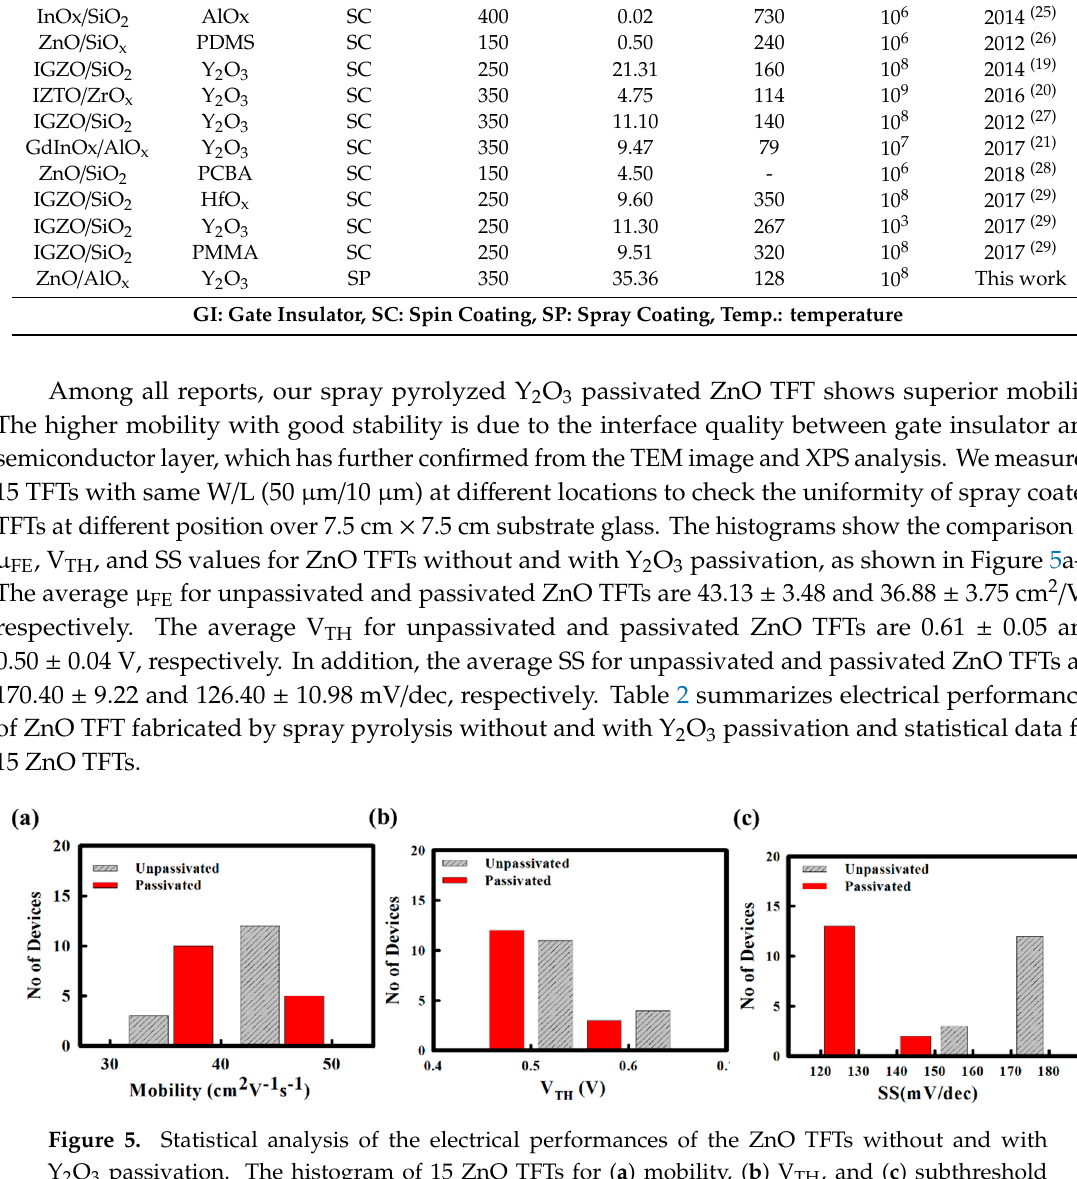
Table 1. The summary of processing methods and electrical performances (field effect mobility, subthreshold swing, and current on/off ratio) of the solution processed oxide TFTs with various passivation layers.